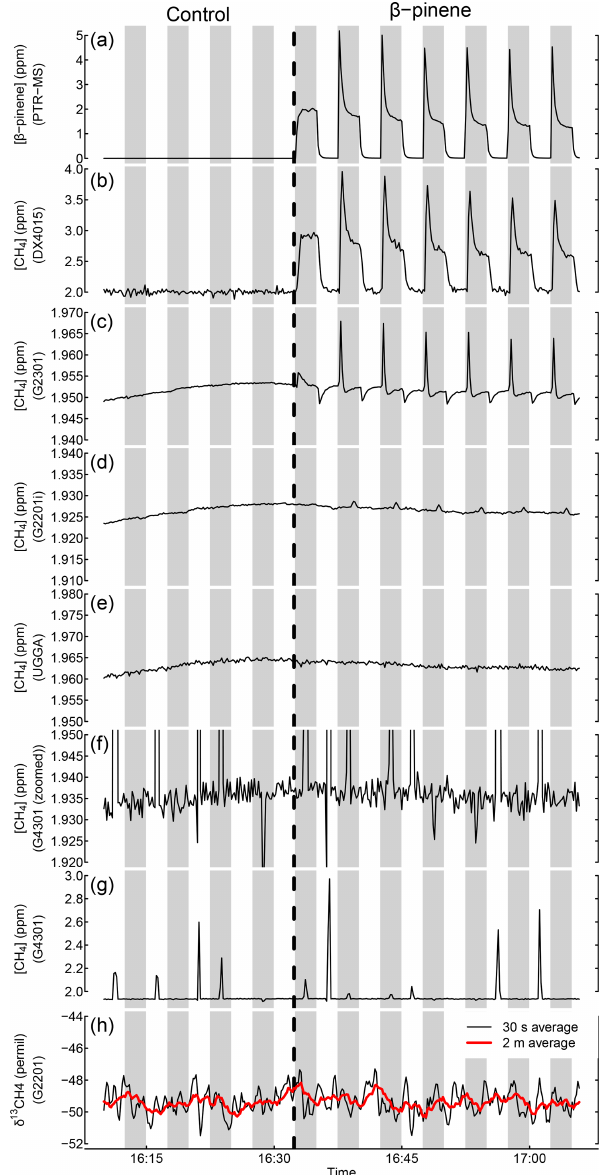
Figure 3. Exemplary results from Experiment 1, shown for tests conducted with β -pinene. The panels show the development of the β -pinene (a) mixing ratio as measured by PTR-MS and the appar- ent CH 4 mixing ratio as measured by Gasmet DX4015 (using an incomplete library intended for soil flux measurements), Picarro G2301, Picarro G2201i, LGR UGGA, and Picarro G4301 (b–g) and δ 13 C–CH 4 values as measured by Picarro G2201i (h) . White areas indicate the times when the system was set to bypass the VOC source, grey shaded areas times when the VOC source was online. During the control period left of the dashed vertical line the VOC source was empty. At the position of the dashed vertical line, the β -pinene vial was introduced into the standard source. Black line represents the 10s moving average of apparent CH 4 mixing ratios and δ 13 C CH values, red thick line the 30s moving average of ap- 4 parent δ 13 C CH values. Notice G4401 results zoomed in panel (f) 4 to visualize background variation; full-scale results in panel (g)